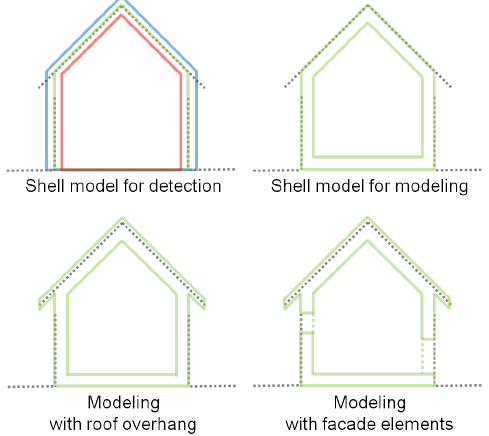
Figure 5. Shell models for building detection and modeling.